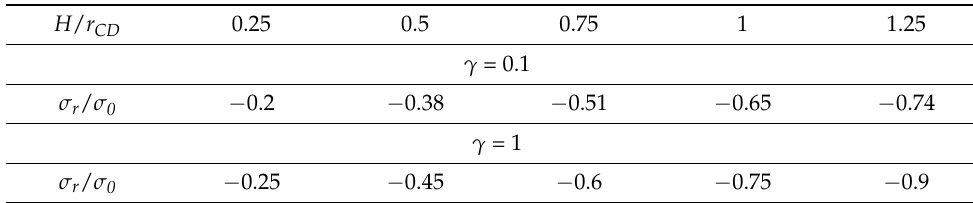
Figure 5. Through ‐ thickness distribution of the circumferential stress at γ = 1 and several process stages.